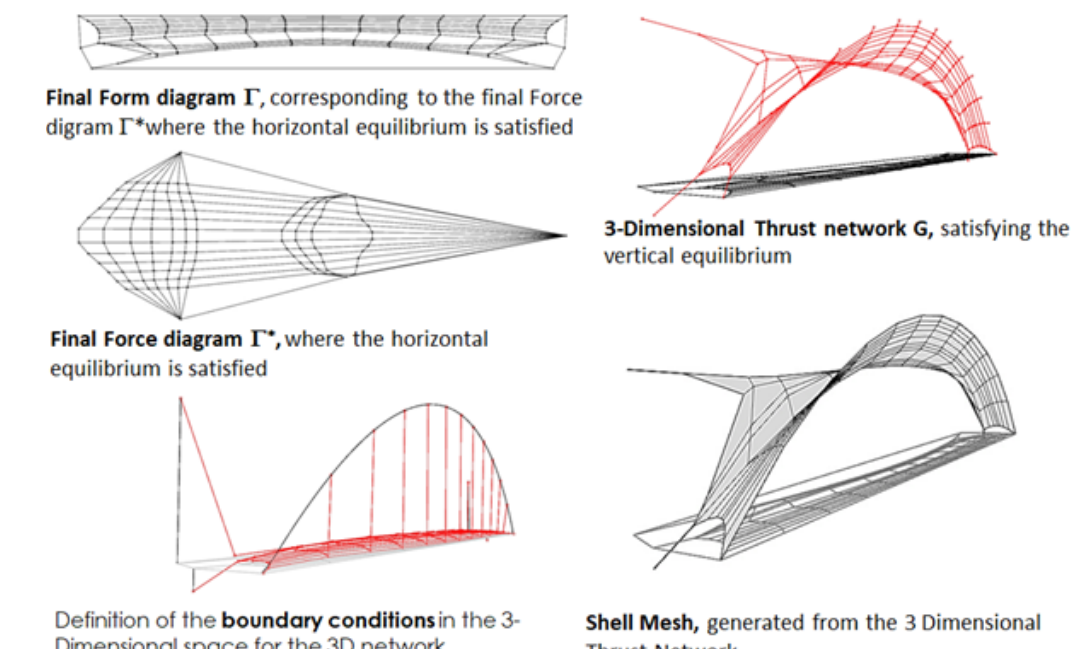
Figure 14: Shell form-finding of the curved shell-supported footbridge using Thrust Network Analysis